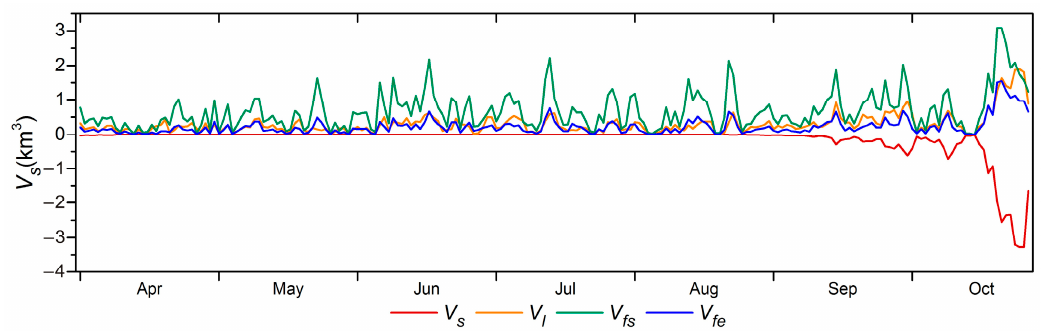
Figure 7. Time series of daily V s , V l , V fs , and V fe in 2005.